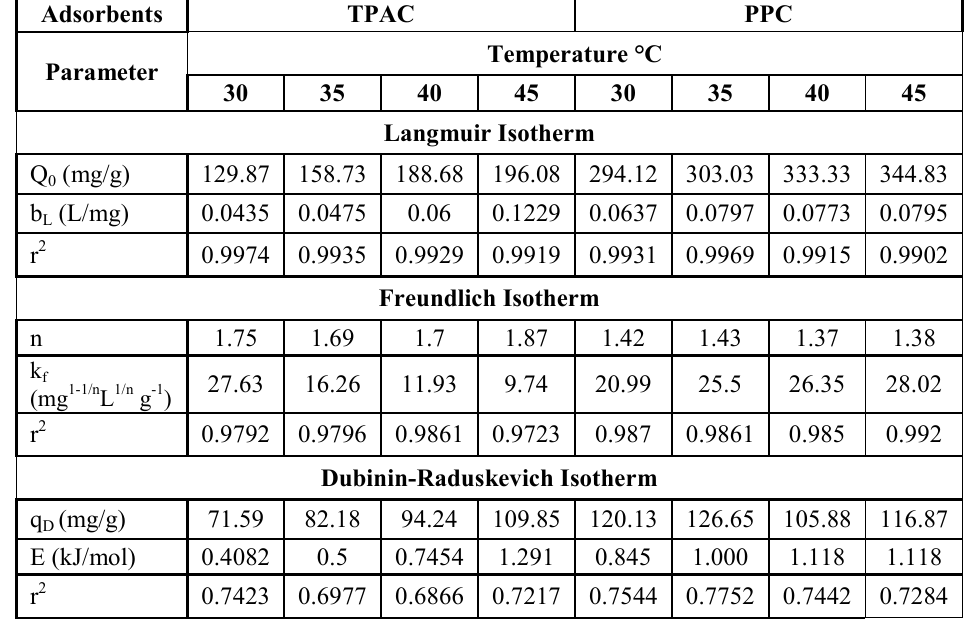
Table 3. Isotherm Constants for the adsorption of direct dye, DB 71 onto TPAC and PPC at various